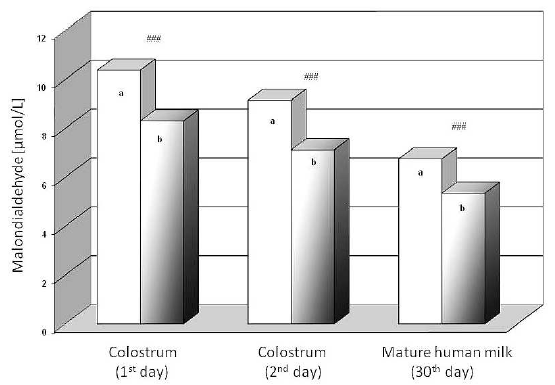
Figure 2. Folic acid effects on MDA levels in colostrum and mature human milk (a - without folic acid; b - with folic acid); ### p < 0.001, ## p < 0.01, # p <0.05 Compared to the values without folic